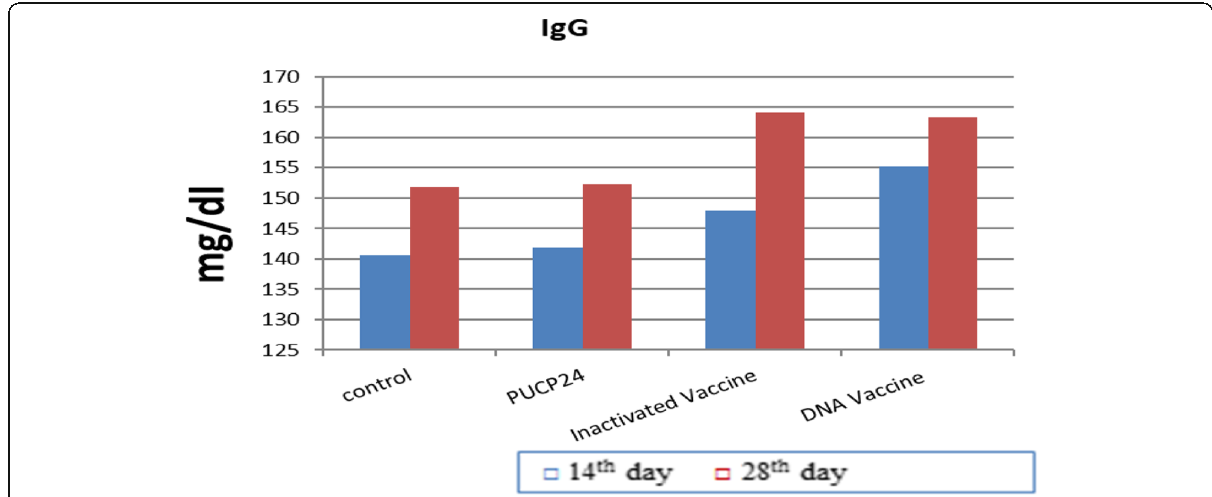
Fig. 7 Serum IgG responses in immunized rats measured by indirect ELISA at the 14th day and 28th day of post-immunization. Each bar represents mean O.D. ± standard error of five pooled serum